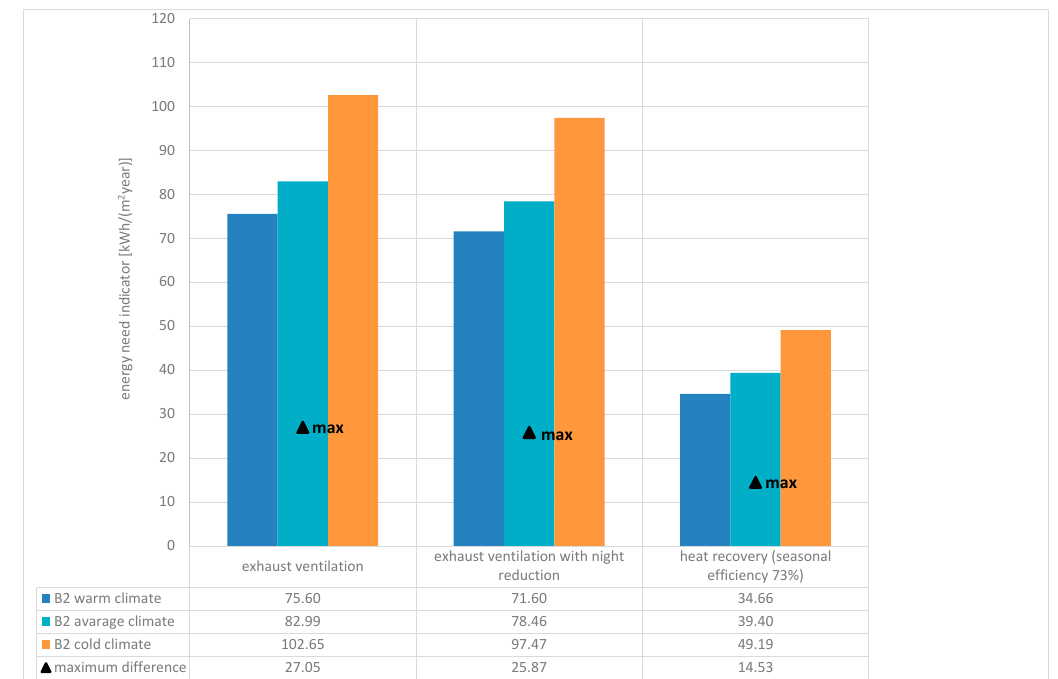
Figure 7. The impact of climate on the energy need indicator for building B2.